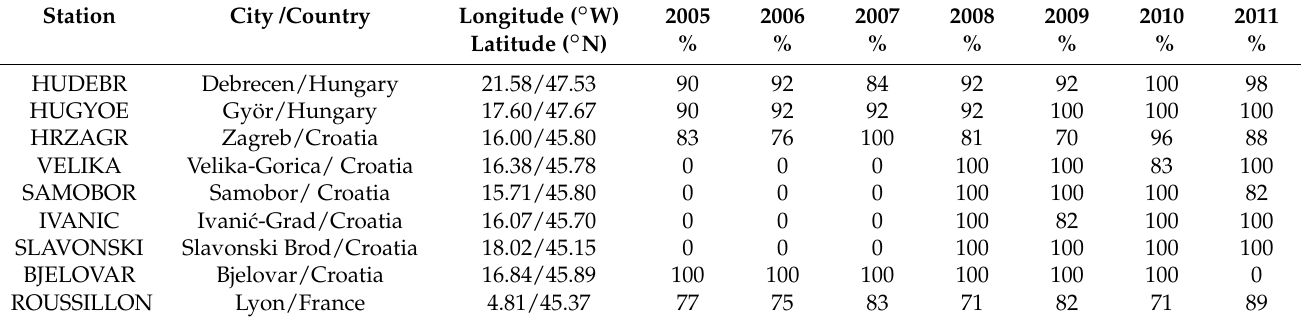
Table 1. List of all Ambrosia measurement stations used in this study. The stations of Debrecen, Györ and Zagreb are operated by the EAN network, the stations of Velika, Samobor, Ivanic, Slavonski and Bjelovar are operated by the HRTEAM network and the station of Roussillon by the RNSA network. For each year, the percentage of available data is given.